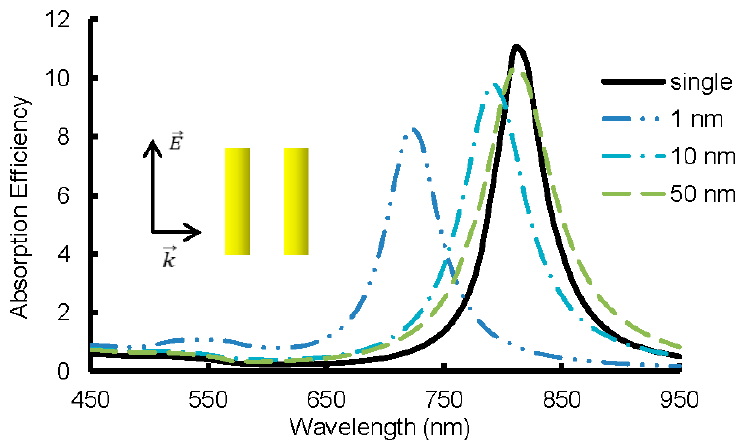
Figure 11. Absorption efficiency of side-by-side assembly with various gaps.